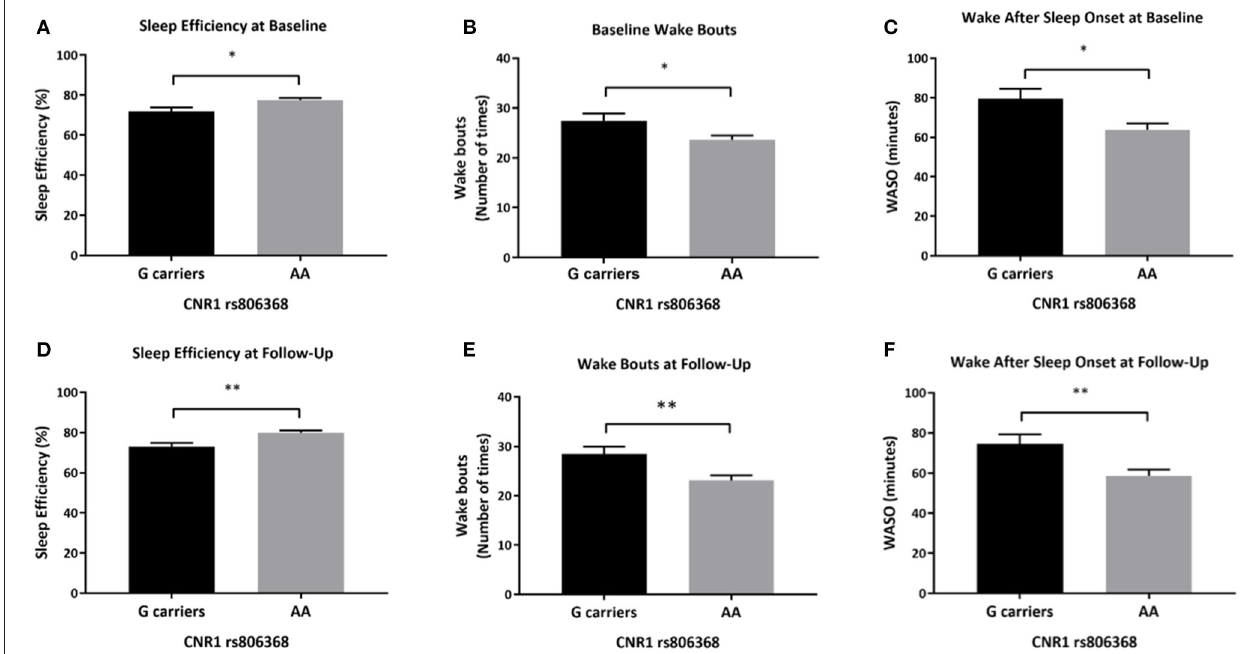
FIGURE 3 | Differences in actigraphy-based sleep quality measures by CNR1 rs806368 genotype at baseline and follow-up. This figure demonstrates that at based on actigraphy-based measures, both at baseline (A–C) and follow-up (D–F) , G carriers of CNR1 rs806368 genotype had poorer sleep efficiency, more wake bouts and more wake minutes after sleep onset after controlling for age, sex, years of education, pack years, Alcohol Dependence Severity (ADS) scores, Ancestry-informative marker (AIM scores for Africa, Europe), presence of mood disorders, and/or anxiety disorders, presence of Cannabis Use Disorder, and/or any Substance Use Disorder other than nicotine. (A) Baseline Sleep Efficiency: [ F (1,89) = 5.324, p = 0.023, N = 101], ( B ) Baseline wake bouts: [ F (1,89) = 4.952, p = 0.029, N = 101], (C) Baseline WASO: [ F (1,89) = 6.174, p = 0.015, N = 101], (D) Follow-up Sleep Efficiency F (1,65) = 9.052, p = 0.004, (E) Follow-up wake bouts: [ F (1,65) = 8.125, p = 0.006], (F) Follow-up WASO: [ F (1,65) = 7.677, p = 0.007]. Bars represent adjusted means and error bars denote standard errors. WASO, Wake After Sleep Onset. * p < 0.05, ** p < 0.01 and Bonferroni